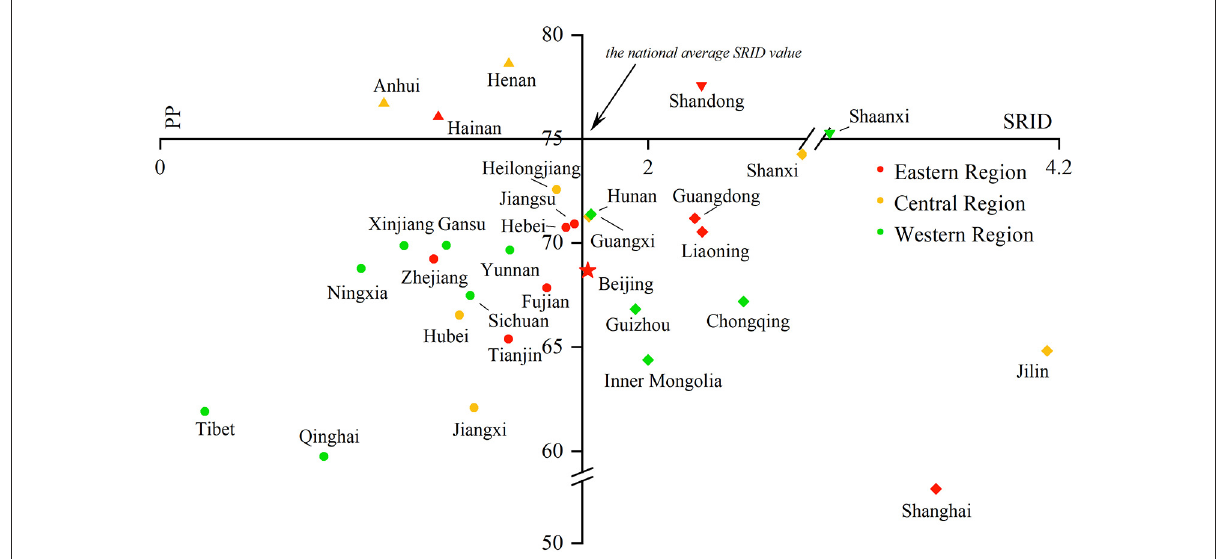
FIGURE7 Scatter plot with four quadrants for the proportion of professionals in 2018.